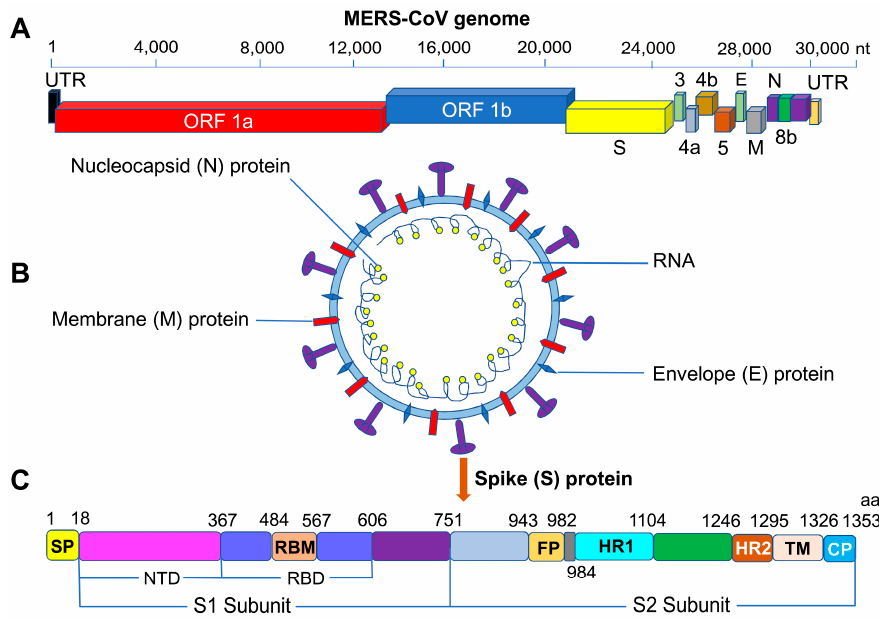
Figure 1. Schematic structures of MERS-CoV S protein. ( A ) MERS-CoV genomic structure, with the untranslated region (UTR), open reading frame regions ORF1a and ORF1b, spike (S), envelope (E), membrane (M), and nucleocapsid (N) genes. ( B ) Schematic structure of the MERS-CoV virion and its major structural proteins. ( C ) Schematic structure of the MERS-CoV S protein and its functional domains, including the N-terminal domain (NTD), receptor-binding domain (RBD), receptor-binding motif (RBM), fusion peptide (FP), heptad repeat region 1 and 2 (HR1 and HR2), transmembrane region (TM), and cytoplasmic tail (CP). aa, amino acid; MERS-CoV, Middle East respiratory syndrome coronavirus; nt, nucleotide.